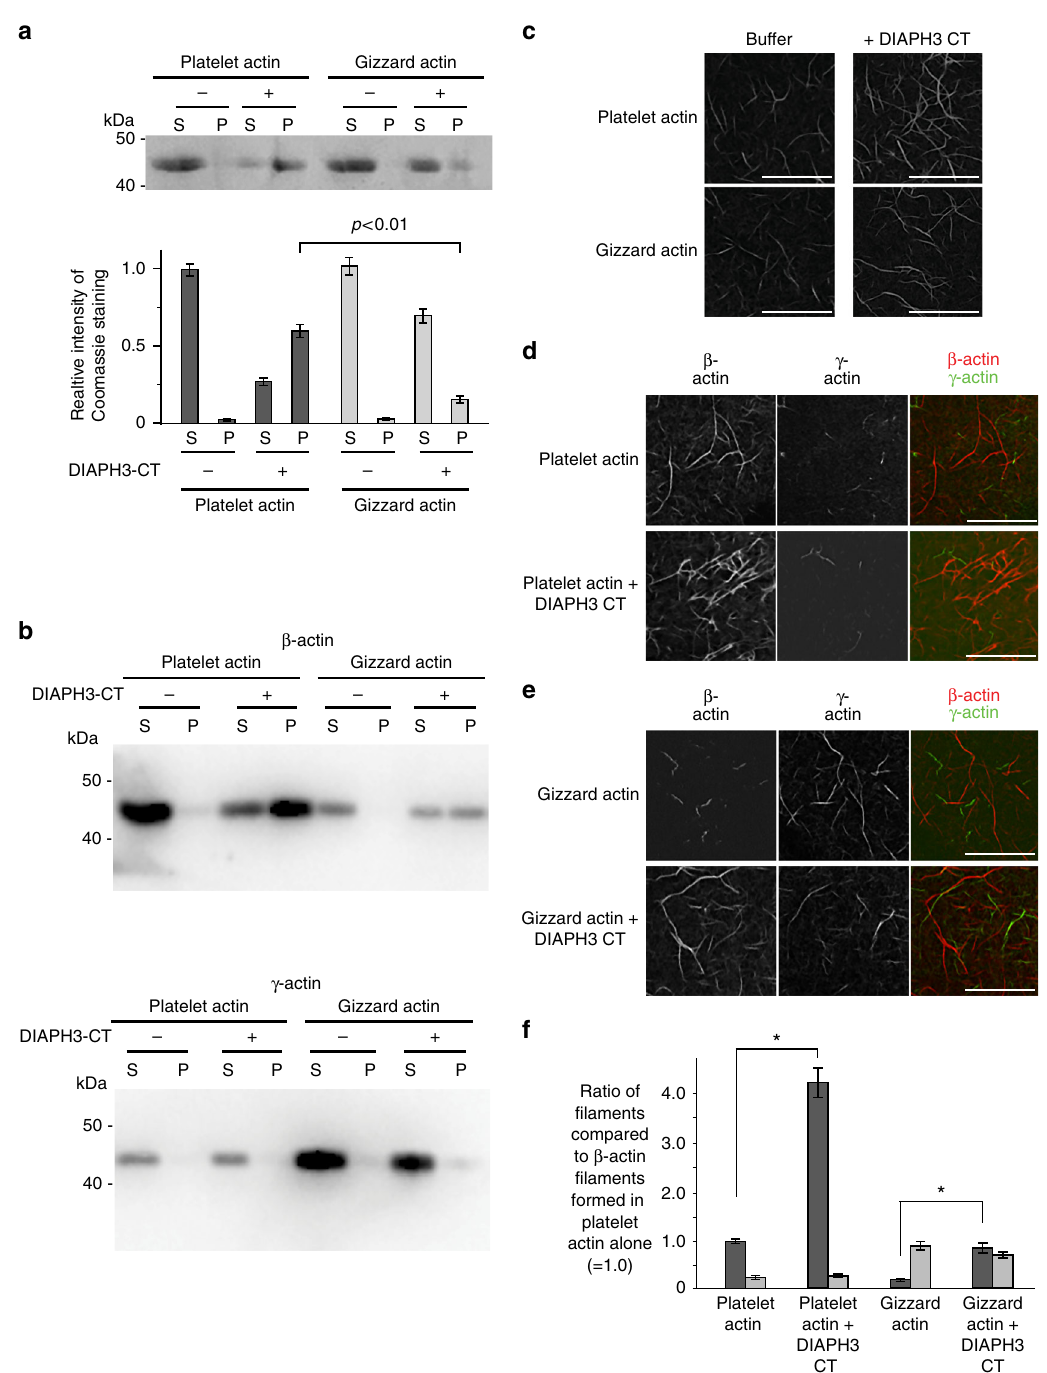
Fig. 5 DIAPH3 preferentially nucleates β -actin fi laments over γ -actin fi laments. a Actin pelleting assay in the presence and absence of GST-DIAPH3-CT using actin isolated from human platelets or chicken gizzard. The polymerization reaction was carried out for 30 min. P = pellet fraction, polymerized actin. S = actin in the supernatant, unpolymerized actin. n = 3. Error bars indicate ± s.e.m. b Immunoblots of the actin pelleting assay in A, probed with β - and γ -actin-speci fi c antibodies. P = pellet fraction, polymerized actin. S = actin in the supernatant, unpolymerized actin. c On glass actin nucleation assay, where actin fi laments are fi xed and visualized by phalloidin staining. d Actin isolated from human platelets nucleated on glass by GST-DIAPH3-CT, fi xed, and stained with β - and γ -actin-speci fi c antibodies. e Actin isolated from chicken gizzard nucleated on glass by GST-DIAPH3-CT, fi xed, and stained with β - and γ -actin-speci fi c antibodies. f Quantitation of the number of fi laments per fi eld relative to the number of fi laments generated upon incubation of human platelet actin in buffer. n = 3. Error bars indicate ± s.e.m. * p < 0.01, Student ’ s t test. All scale bars are 10 μ